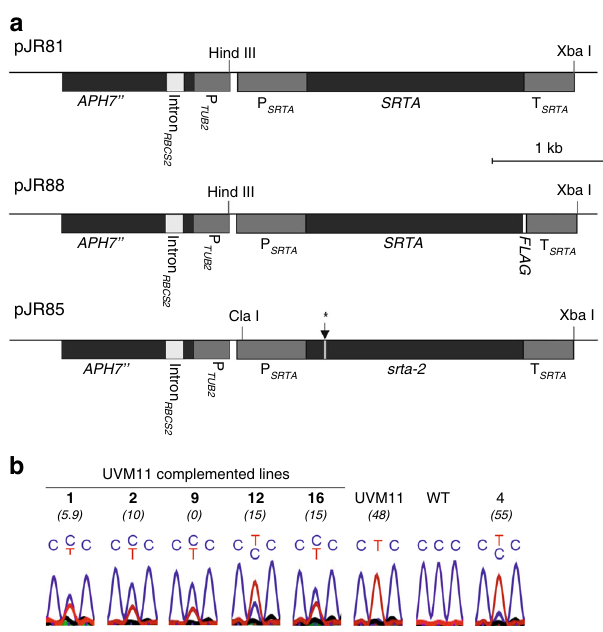
Fig. 4 Complementation of the uvm mutants with the wild-type SRTA allele. a Physical map of the transformation vectors used for complementation of strains UVM4 and UVM11. Exons are shown in black, introns in light gray, and promoter and terminator sequences in dark gray. Expression of the SRTA cDNA is driven by the native SRTA promoter (P SRTA ), 5 ’ UTR, and 3 ′ UTR (T SRTA ). The hygromycin resistance gene APH7 ” under control of the TUB2 promoter was used as a selectable marker.